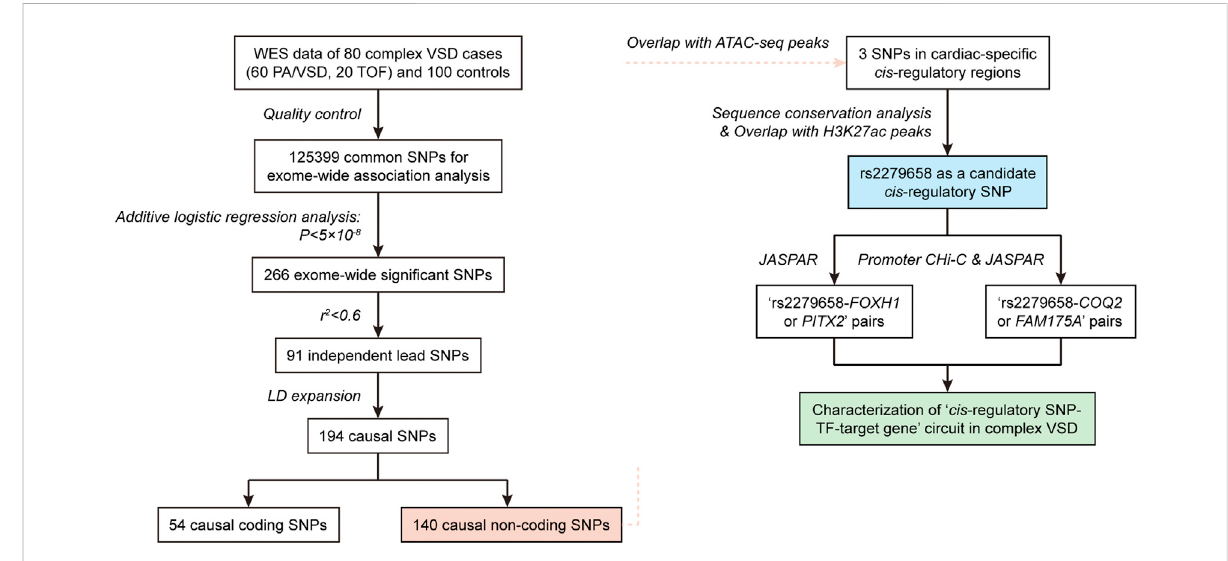
FIGURE 1 Flowchartshowingtheintegrated pipeline usedto recognize tripletsof cis -regulatory SNP,corresponding TFand target gene